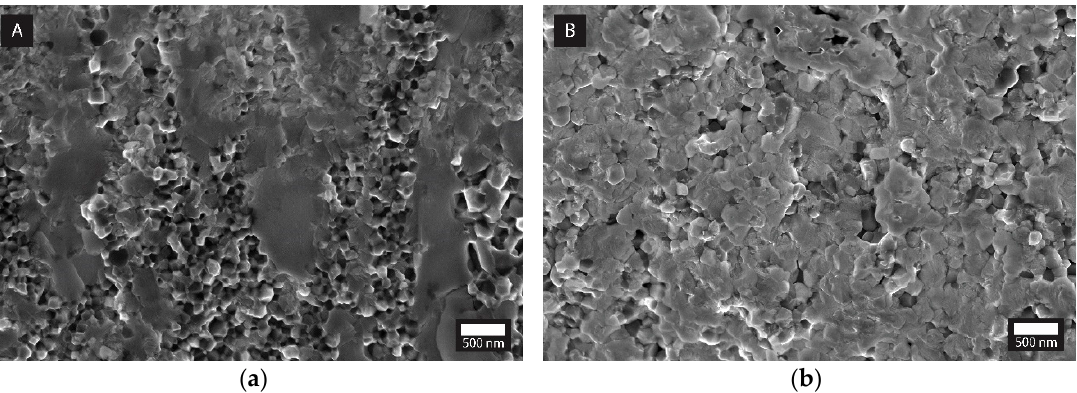
Figure 7. SEM micrographs of fracture cross-sections for ZrO 2 -30TiN nanocomposites ( a ) ISS, ( b ) MCP.